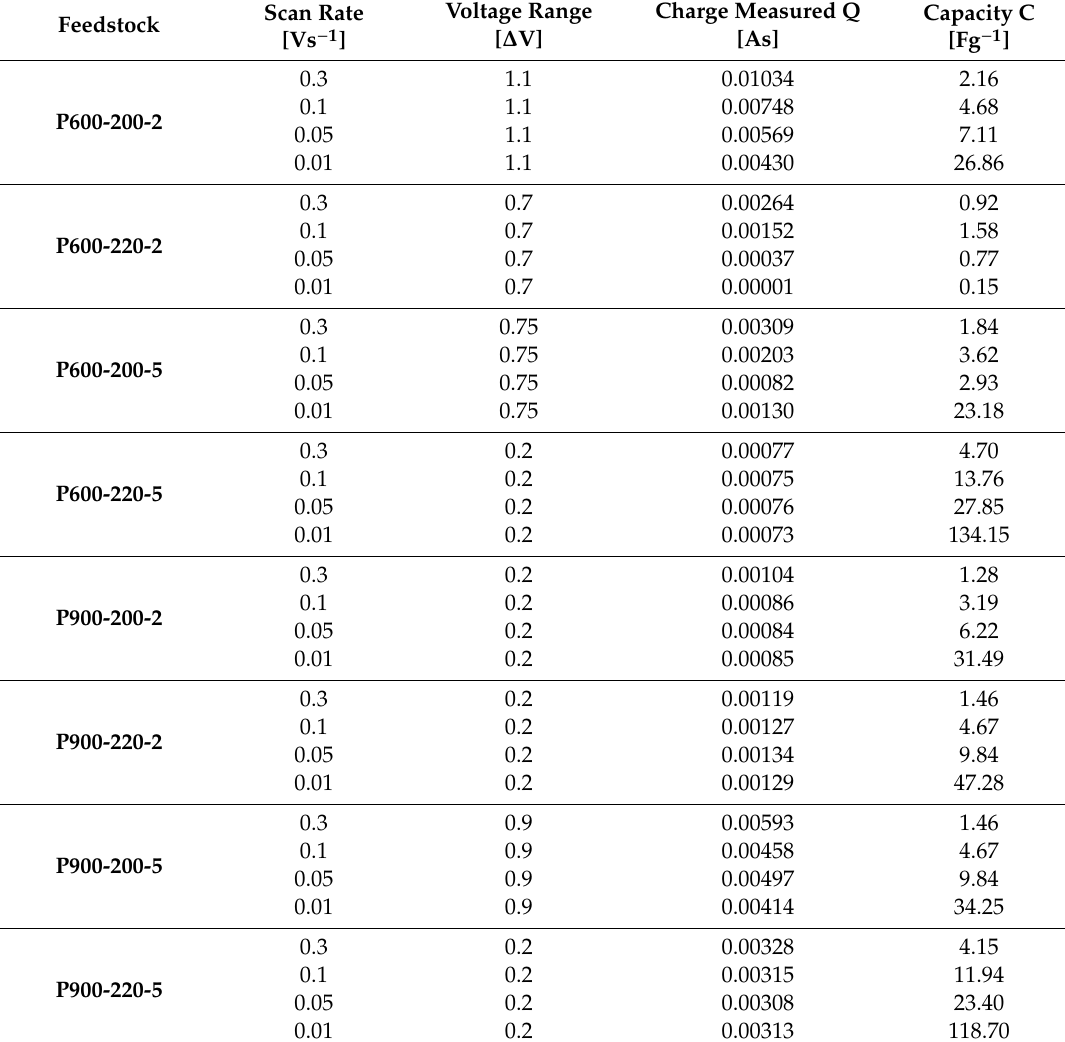
Table 3. Conditions and results of cyclovoltametric